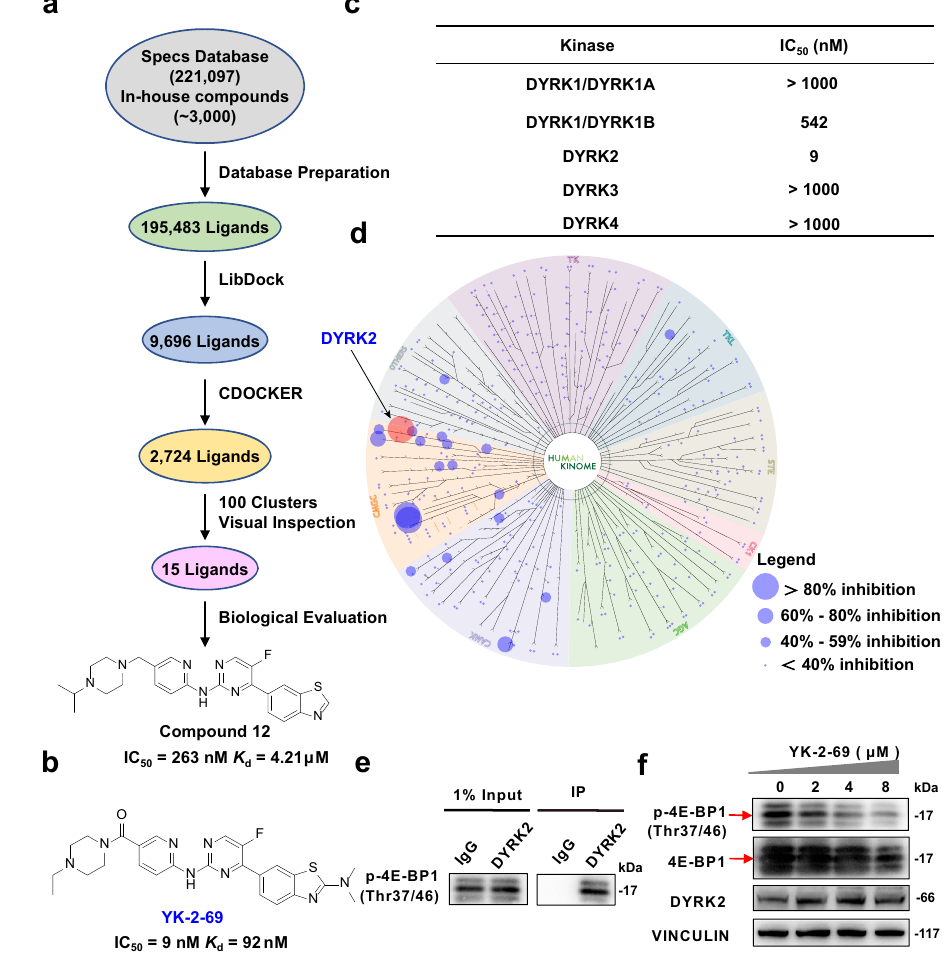
Fig. 3 Discovery of the highly selective DYRK2 inhibitor YK-2-69. a Flowchart of virtual screening to discover the hit DYRK2 inhibitor compound 12 . b Chemical structure and activities of YK-2-69. c Inhibitory activity of YK-2-69 against DYRK1A, 1B, 2, 3, and 4. d Kinase selectivity experiment of YK-2-69 (1 µ M) was carried out at Reaction Biology Corporation (https://www.reactionbiology.com/). The dot size indicates the inhibitory rate. A dot represents a type of kinase and the red dot represents DYRK2. e Validation of interaction of p-4E-BP1 (Thr37/46) with DYRK2 by co-immunoprecipitation assay. 1% volume of cell lysate was used as input. f Western blotting analysis of indicated proteins after treatment with DMSO or YK-2-69 for 48 h. The special bands of 4E-BP1 and p-4E-BP1 were shown with arrows. Source data are provided as a Source Data fi